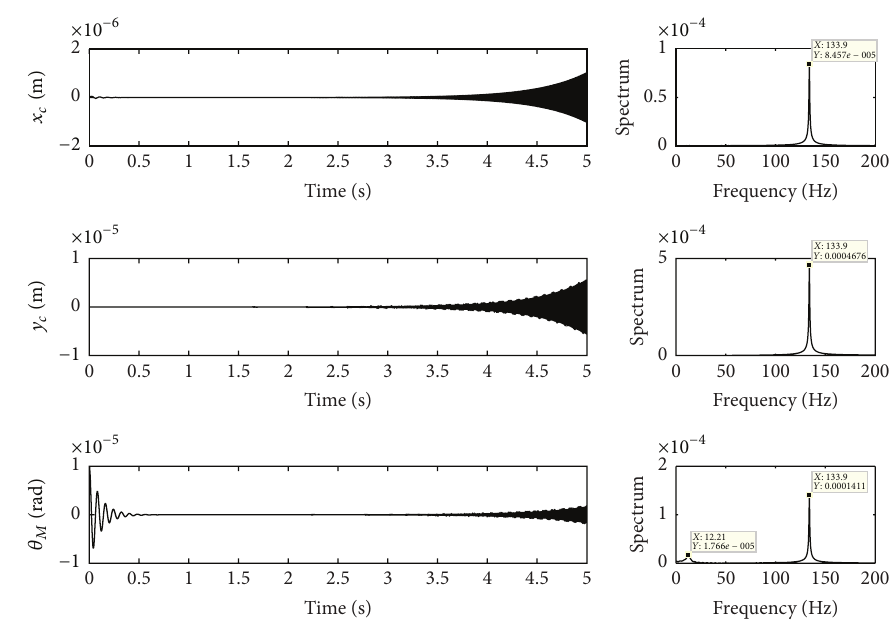
Figure 9: Dynamic response to the variation in roll rotational angle for V 𝑟 = 21 m ⋅ s −1